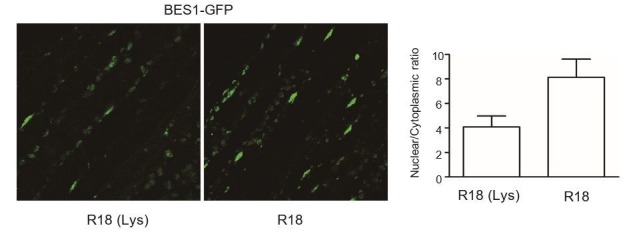
The effect of R18 on the localization of BES1-GFP.BES1-GFP transgenic plants (a gift from Dr. Xuelu Wang’s lab) grown under white light were treated with R18 or R18(Lys) for 3 hr after 10 min of vacuum. ImageJ was used to quantify the fluorescence intensities. Ratios between the nuclear and cytoplasmic signal intensities were calculated from at least 10 cells for each treatment.